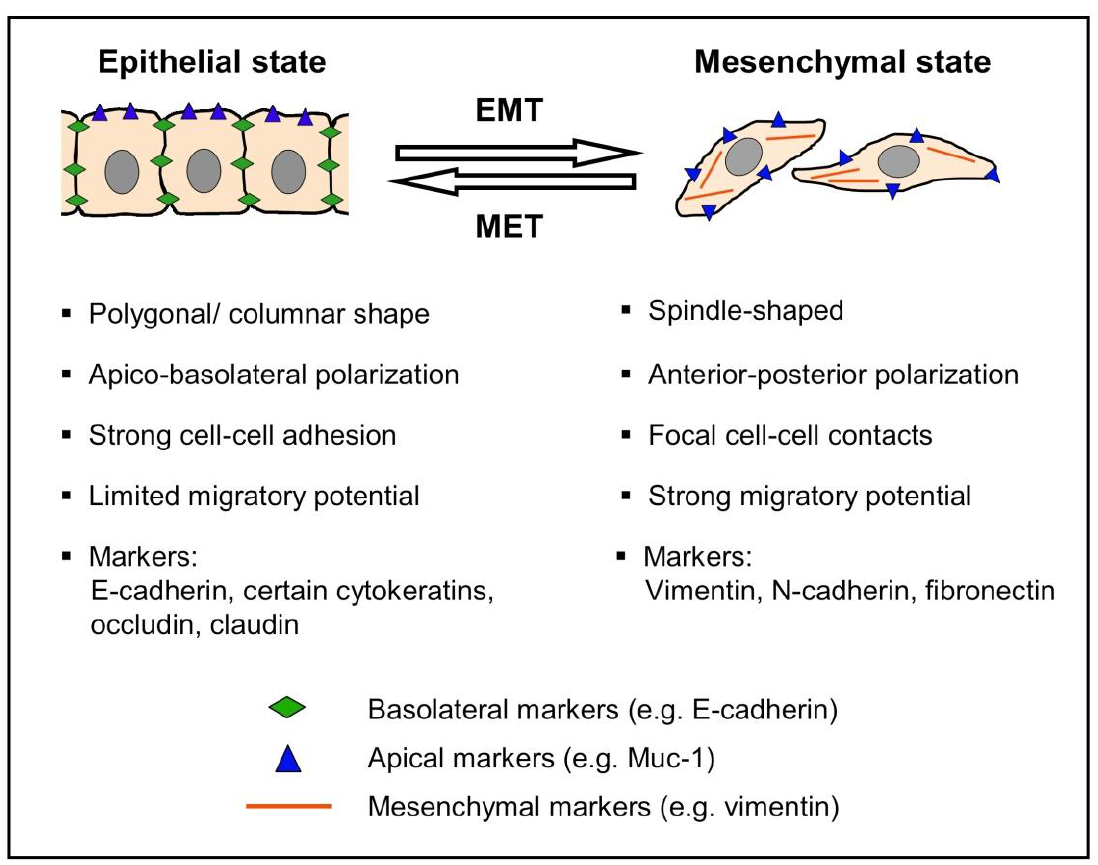
Figure 1. Characteristics of epithelial-mesenchymal transition. EMT: